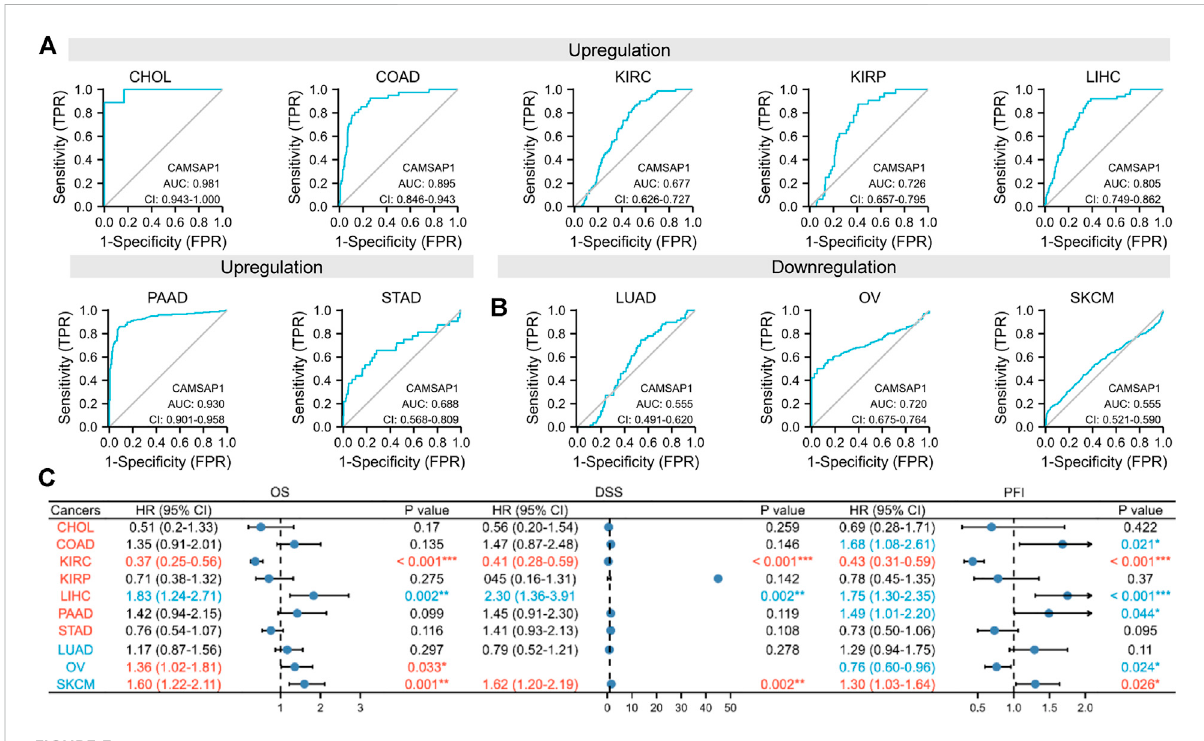
FIGURE 3 Differentially expressed CAMSAP1 serves as a potential diagnostic and prognostic biomarker in some cancers. (A,B) ROC analyses of CAMSAP1 . (C) A forest plot of survival analyses with OS, DSS, and PFI. * p < 0.05, ** p < 0.01, *** p <